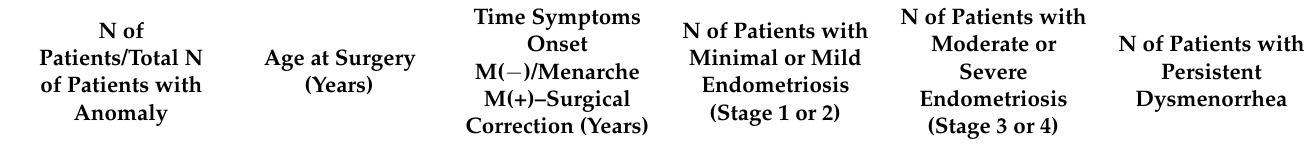
Table 3. Characteristics of 17 adolescents diagnosed with endometriosis at the time of surgical correction. N: number; M( − )—in adolescents with cryptomenorrhea; and M(+)—in adolescents with menses.